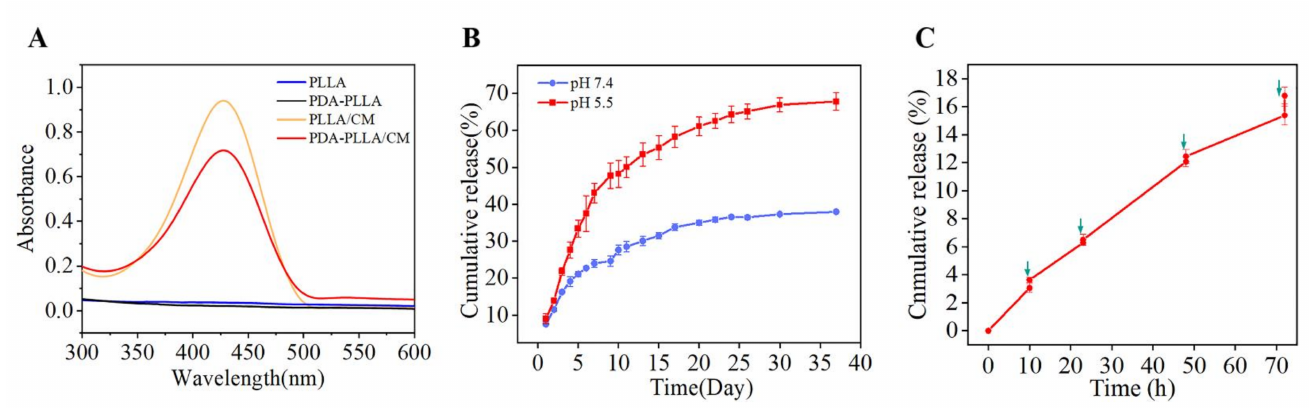
Figure 3. Drug-loading character of microparticles. ( A ) UV − Vis absorption spectra of PLLA/CM and PDA-PLLA/CM microparticles for CM (425 nm). ( B ) CM release curves under different pH. ( C ) NIR-response release of CM for 10 min (pH 5.5, 1.3 W/cm 2